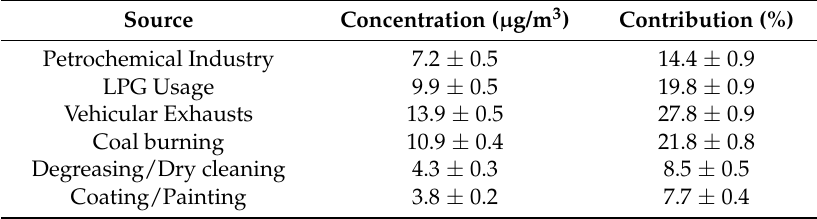
Table 2. Source contributions to VOCs (Volatile Organic Compounds) at Wuhan, China